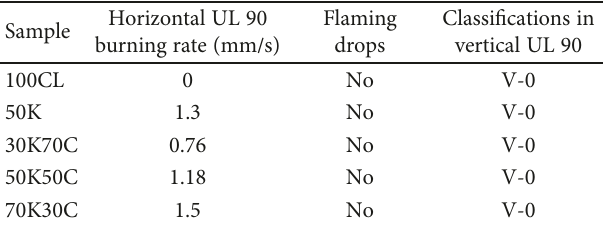
Table 4: Flammability results of recycled carbon/kenaf/cardanol hybrid